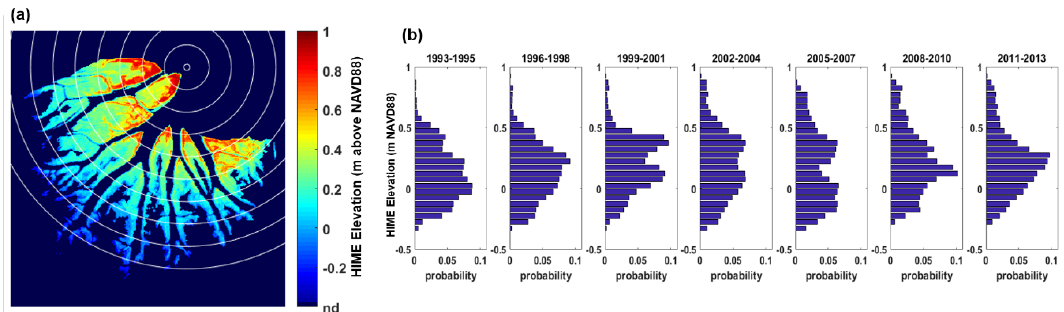
Figure 6. ( a ) Map of HIME marsh-top elevations for WLD in the 2011–2013 timeframe. Maps for the other six timeframes are in the Supplementary Materials, Figure S3. ( b ) Time series of probability distributions of WLD HIME elevations (in 0.05 m bins) from 1993–1995 (left) to 2011–2013 (right). As in the Pintail Island test case, the entire WLD exhibited progressive topographic di ff erentiation between the lagoon / mudflat island interiors and the higher island levees over time. Areas at moderate elevations at early times (0.0–0.5 m NAVD88, 1993–1998) appeared to bifurcate over the